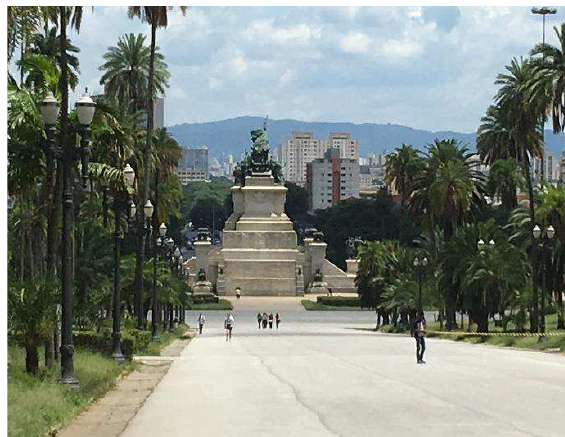
Figure 9. Monumento à Independência do Brasil: central perspective view from Museu do Ipiranga and the relationship with the Parque da